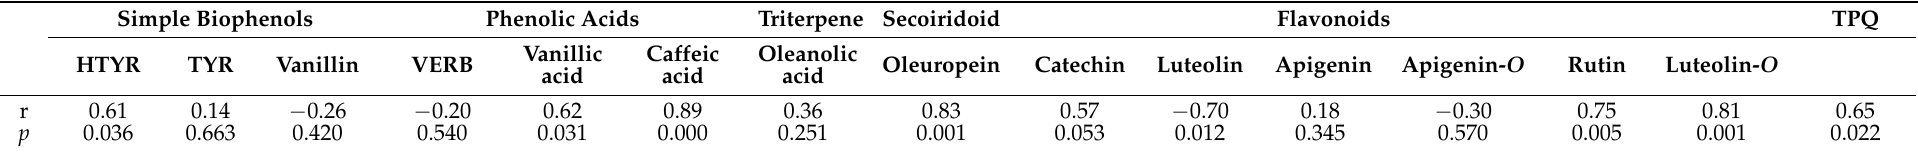
Table 2. Correlation coefficients between the total per plant quantity of Mn and simple biophenols, phenolic acids, and flavonoids of ‘Istarska bjelica’ olive cv. treated with three different manganese (Mn) concentrations.